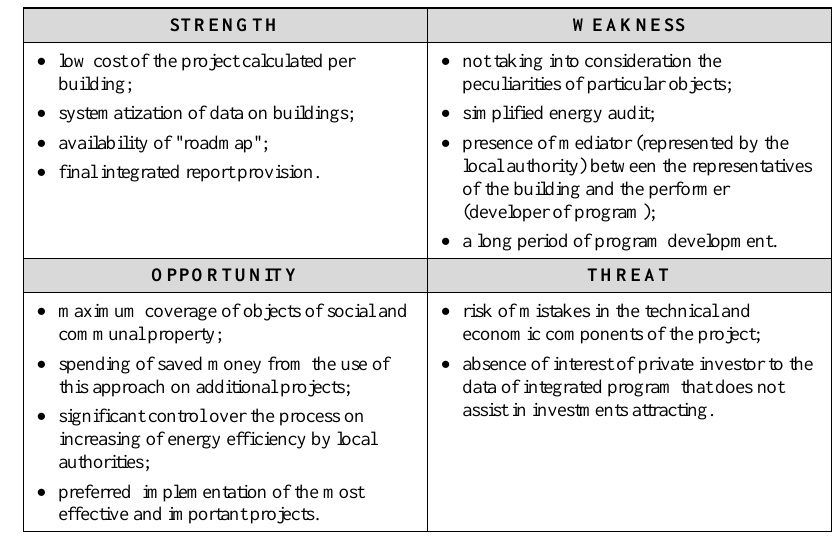
Fig. 2. SWOT-analyzes of integrated program approach for developing energy saving